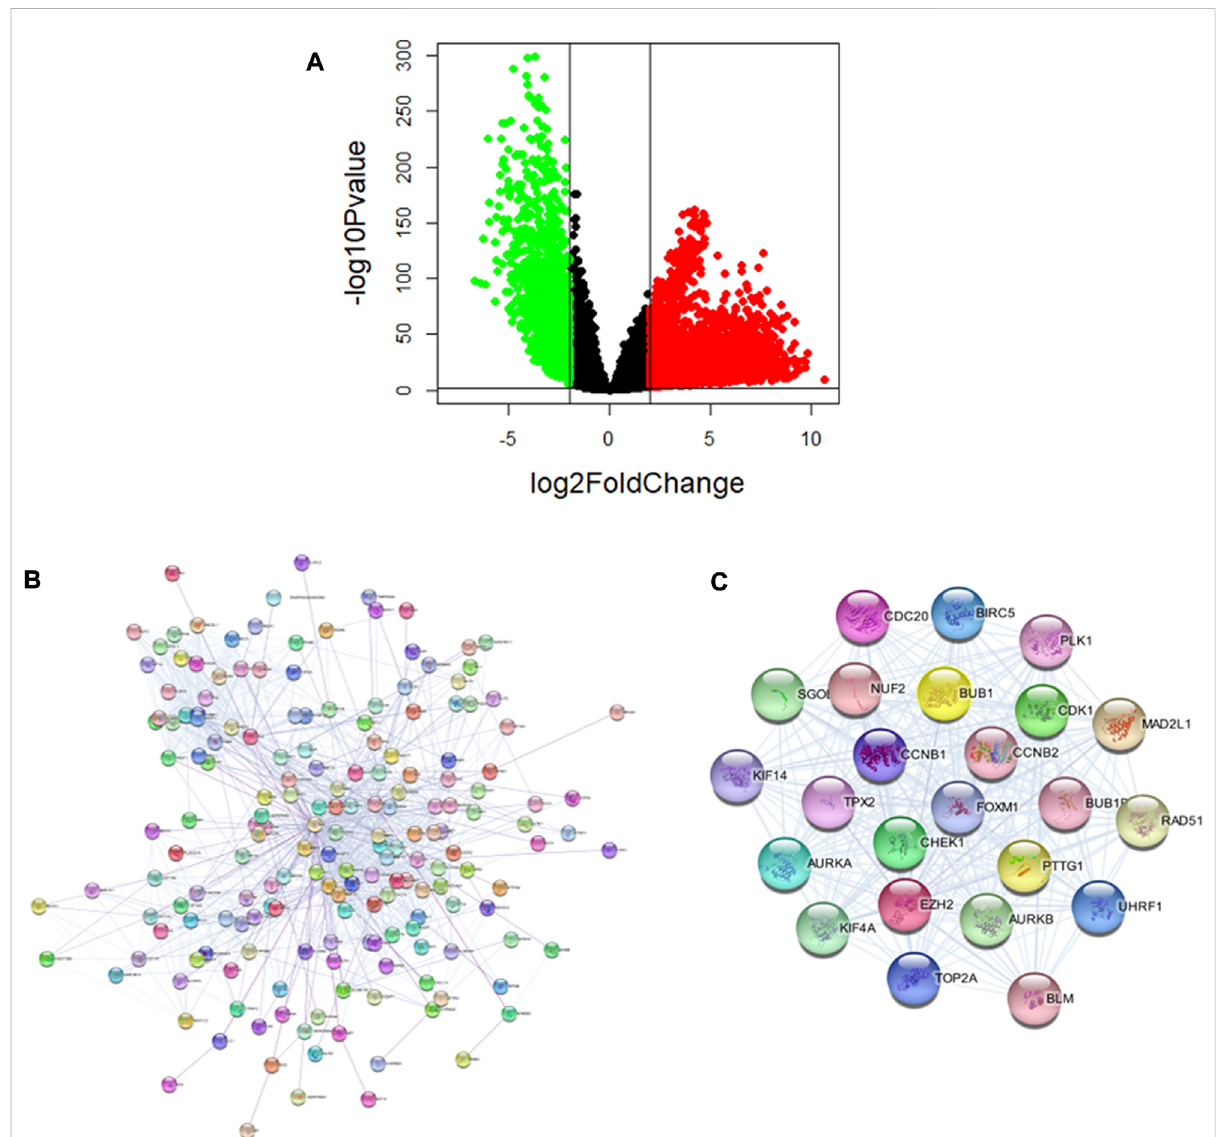
FIGURE 4 AnalysisofpathogenicgenesofLungcancer. (A) Signi fi cantDEGsoflungcancer. (B) PPInetworkoflungcancerpathogenicgenes. (C) Thesub- networks were identi fi ed by Cytoscape MCODE